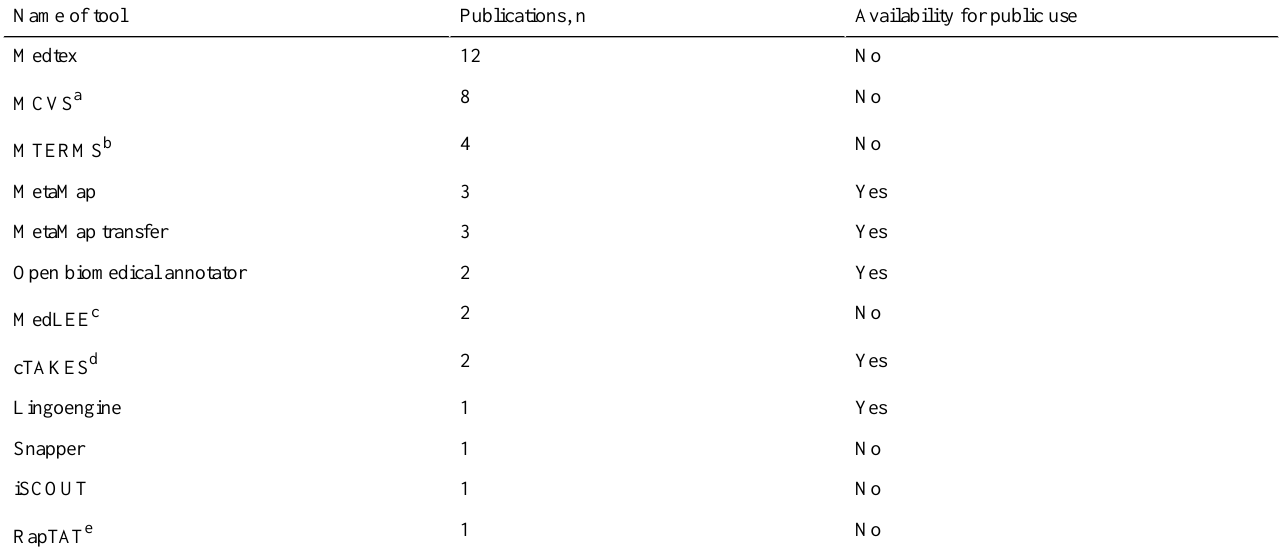
Table 7. Tools used for mapping free text to Systematized Nomenclature of Medicine Clinical Terms